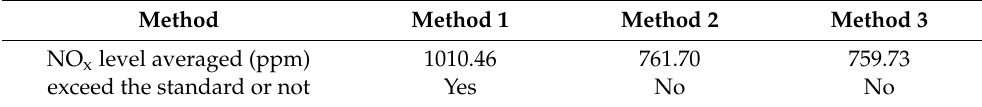
Table 2. Results obtained by the three methods for the excessive emission determination.